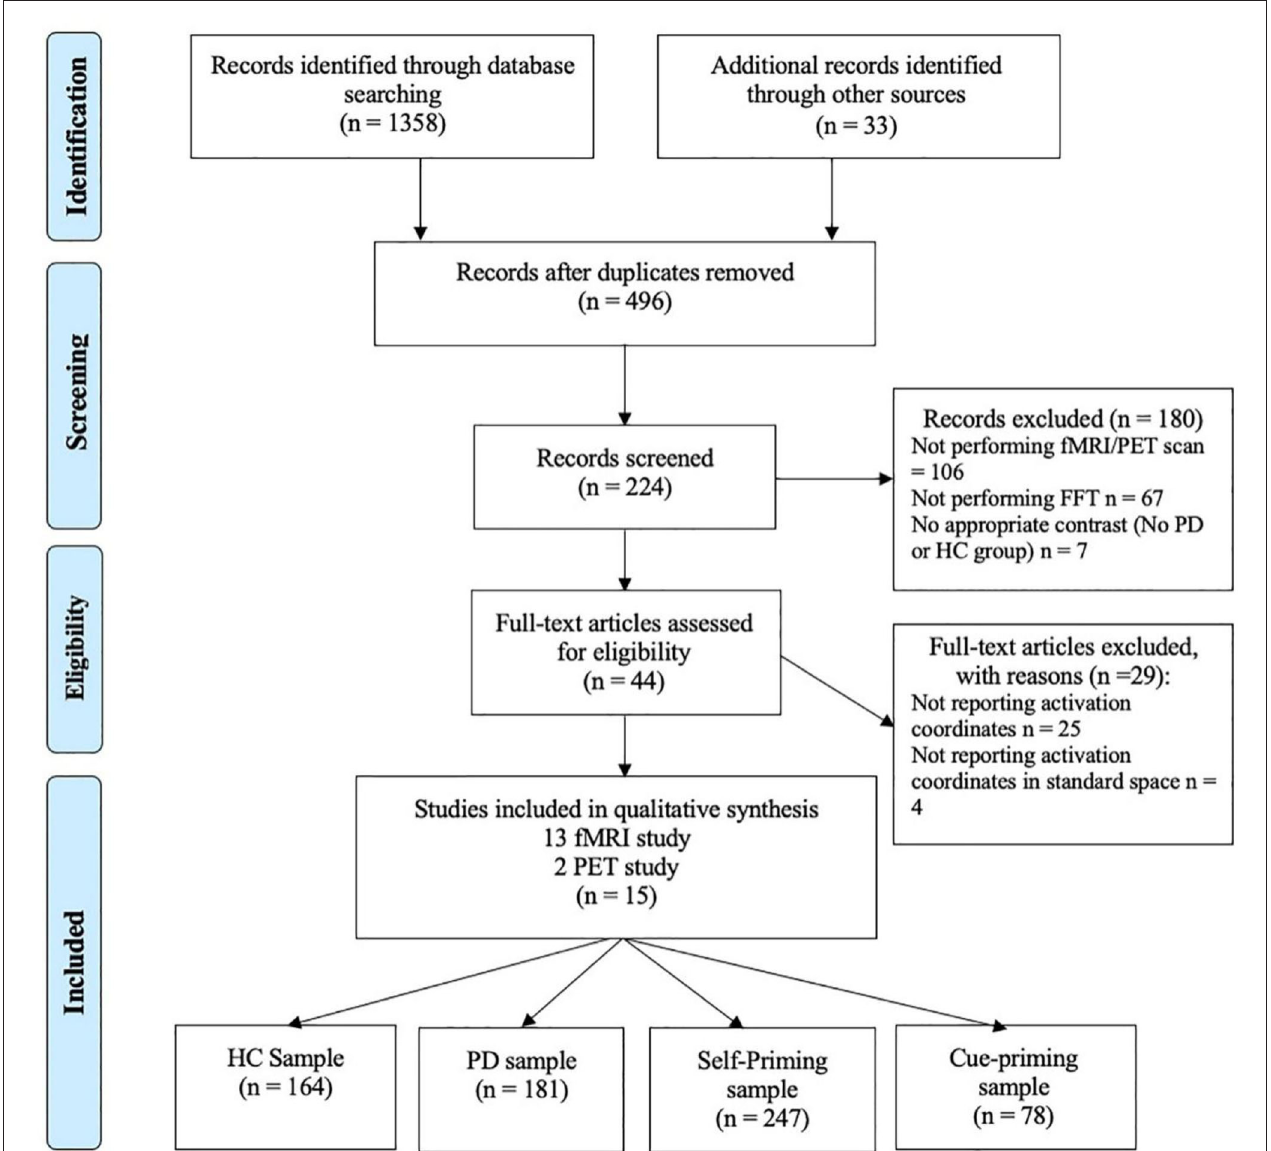
FIGURE 1 | PRISMA flow diagram depicting identification, screening, and inclusion strategies for the selection of the reviewed studies.